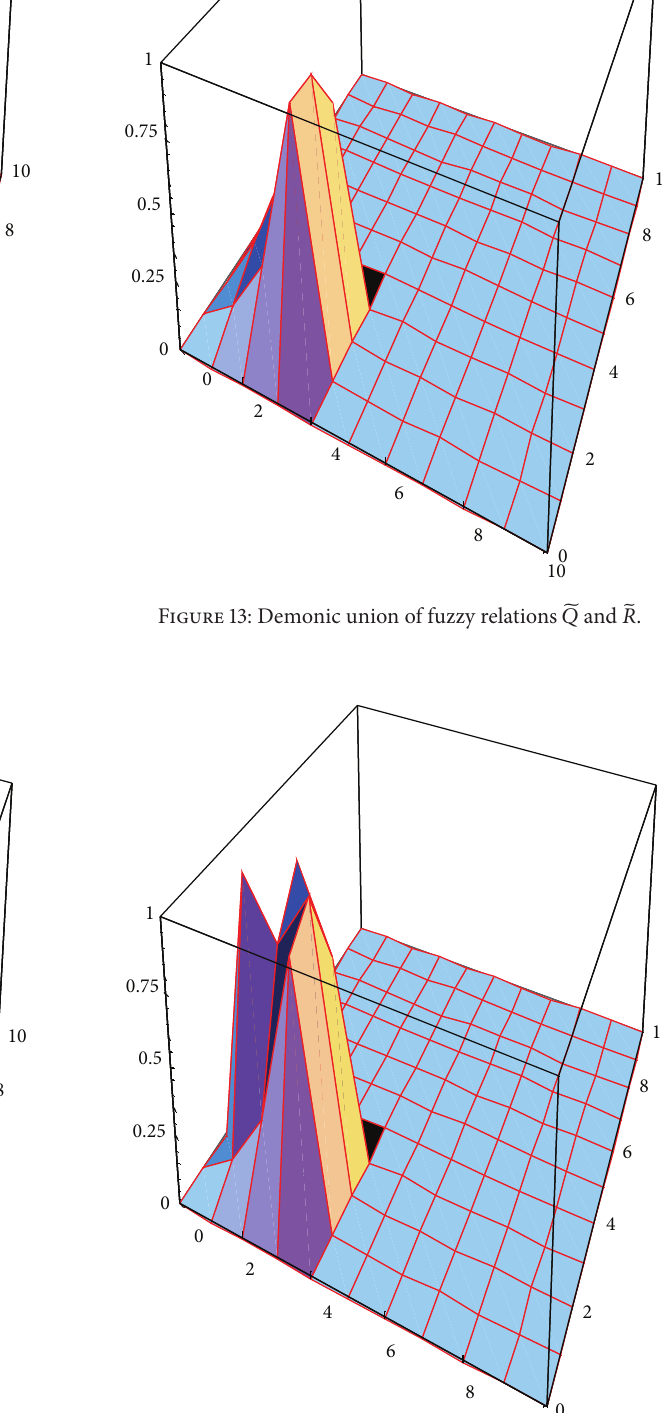
Figure 12: A demonic fuzzy relation